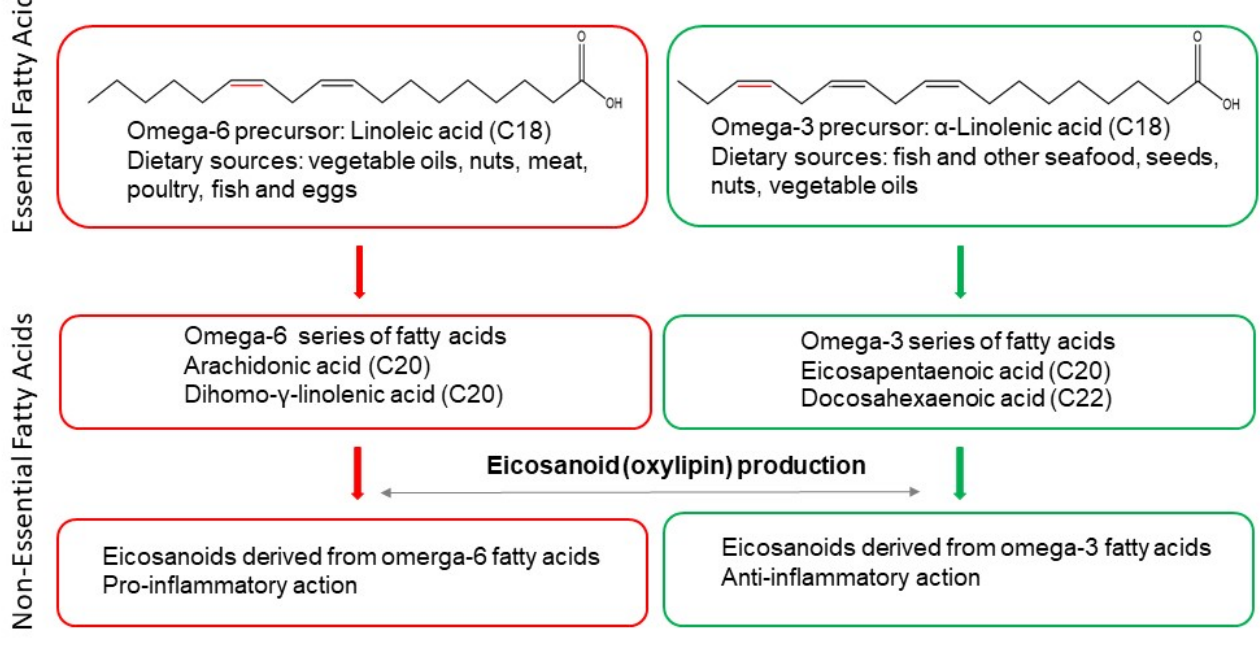
Figure 1. General overview of essential and non-essential polyunsaturated fatty acids. LA is a non-essential fatty acid and precursor of the omega-6 series of fatty acids and eicosanoids which have mostly pro-inflammatory action. ALA is a non-essential fatty acid and precursor of the omega-3 series of fatty acids and eicosanoids which have predominantly anti-inflammatory effect. Omega-6 and omega-3 double bonds are marked in red. Chemical formulas were created using ChemDraw ® . More detailed description of the role of PUFAs in inflammatory processes, including exceptions, is outlined in the main text.